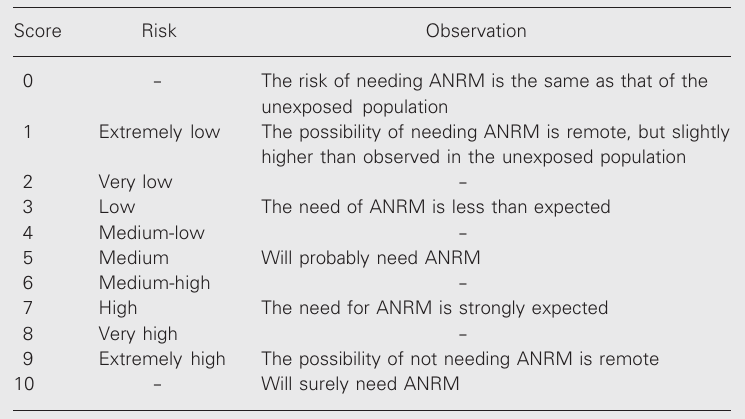
Table 1. Reference risk scoring